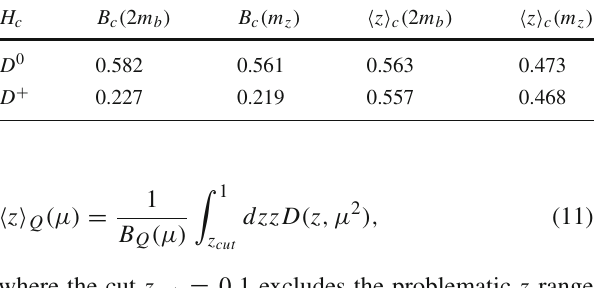
Table 5 The values of B c (μ) and (cid:7) z (cid:8) c (μ) for the D + and D 0